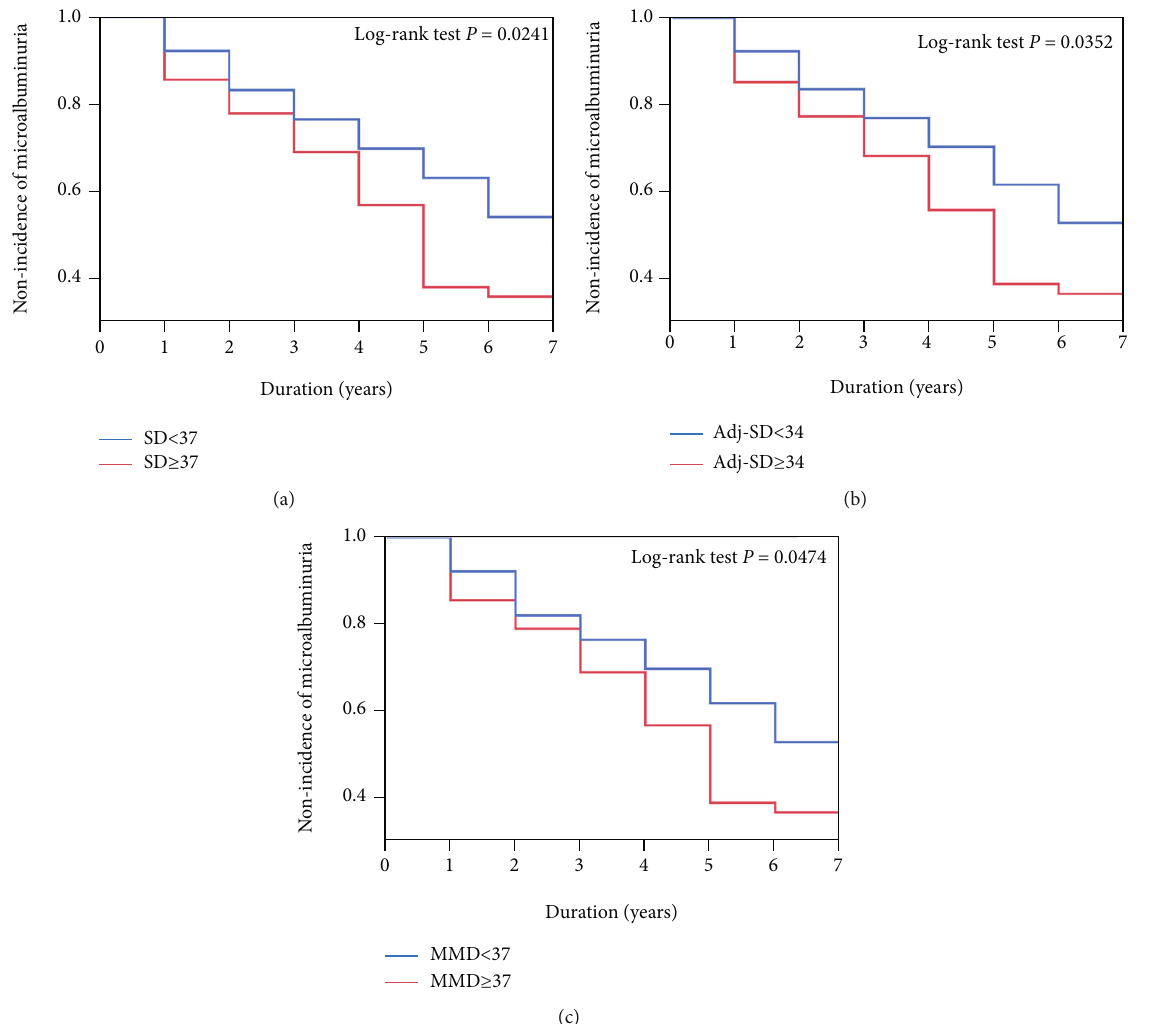
Figure 3: Comparing the seven-year nonincidence of microalbuminuria between groups divided by the median values of SD, Adj-SD, and MMD. TG: triglyceride; SD: standard deviation; Adj-SD: SD adjusted for the number of measurements; MMD: maximum minus minimum di ff erence.